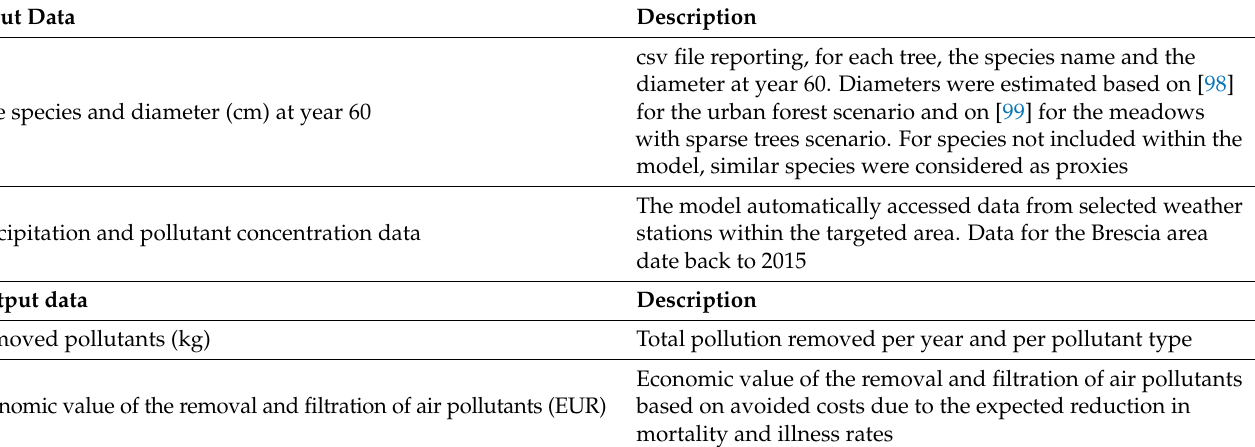
Table 5. Input and output data for the assessment and evaluation of removal and filtration of air pollutants.